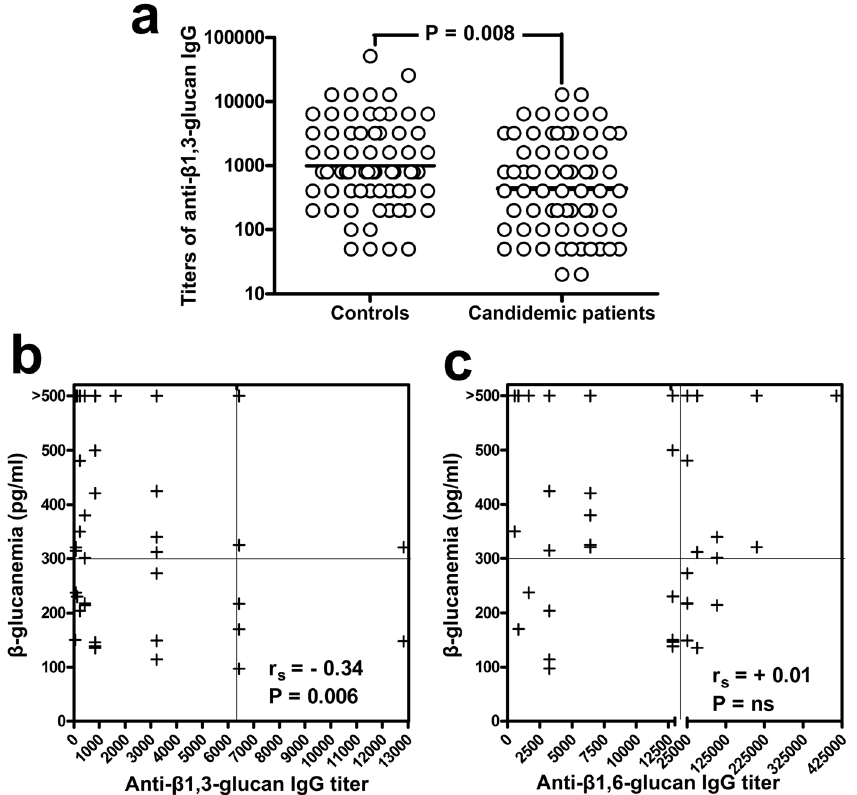
Figure 1. Serum titers of anti- β 1,3-glucan IgG are lower in candidemic patients than in controls, and are inversely correlated to levels of circulating β 1,3-glucan. Panel a: Individual, anti- β 1,3-glucan IgG titers in patients with candidemia (n = 71) and in non-candidemic controls (n = 69). A single serum samples was analyzed for each subject. For candidemic patients, sera were those obtained at onset of candidemia, i.e. from the same blood specimen of the first Candida -positive blood culture. Geometric means are indicated by the lines. P was estimated by the Mann-Whitney U test. Panels b and c: Correlation between serum titers of anti- β 1,3-glucan ( b ) or anti- β 1,6-glucan ( c ) IgG and beta-glucanemia in candidemic patients. Correlation coefficients r s and P values were calculated by the Spearman’s rank correlation analysis.